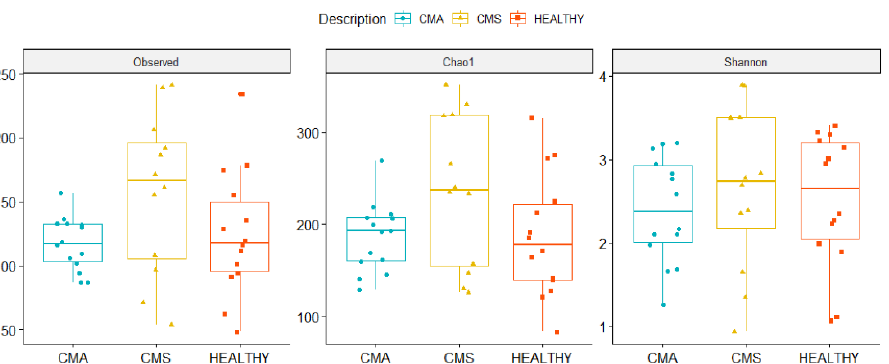
Figure 3. Boxplots representing alpha-diversity computed by Observed, Chao1 and Shannon in- dexes in the three CMA, cow’s milk sensitized (CMS), and HEALTHY groups. Boxes represent the median, 25th and 75th percentiles calculated for CMA (blue), CMS (yellow), and HEALTHY (red) groups.